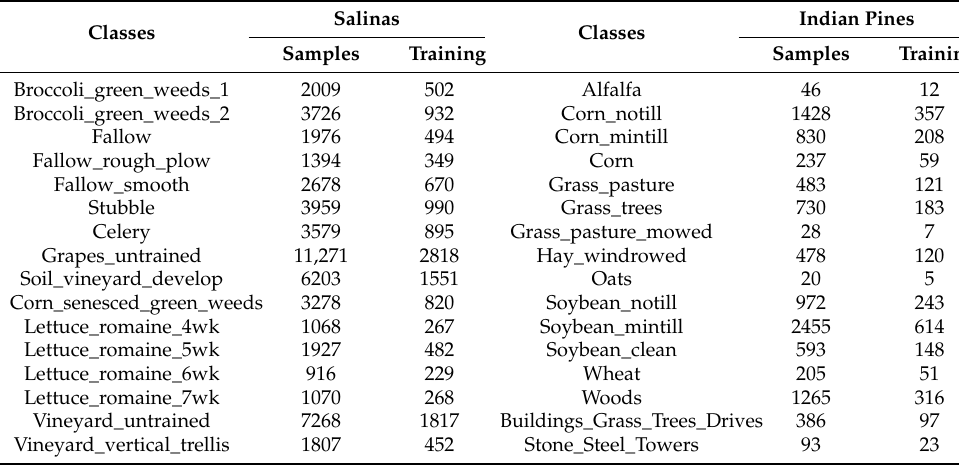
Table 3. Samples and training samples used for the Salinas and Indian Pines datasets.